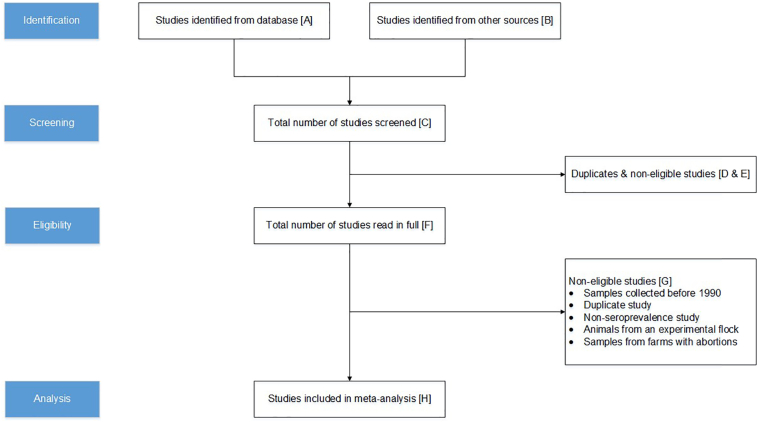
PRISMA flow-diagram shows the procedure for the selection of the eligible studies. The number of studies removed and selected at each step is marked with letters A–H and this information is displayed by host species in Table 2.